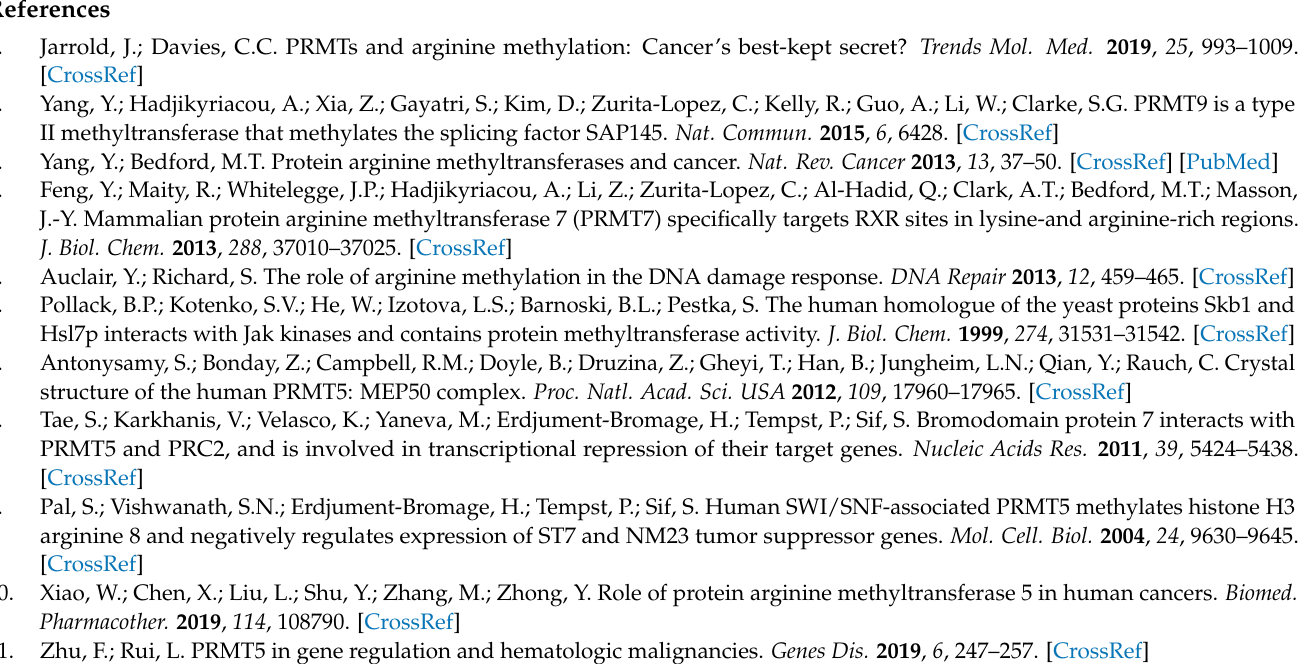
Table S1: intravenous injection of 2 mg/kg compound 20 in male mice pharmacokinetic parameters. Table S2: gavage of 10 mg/kg compound 20 in male mice pharmacokinetic